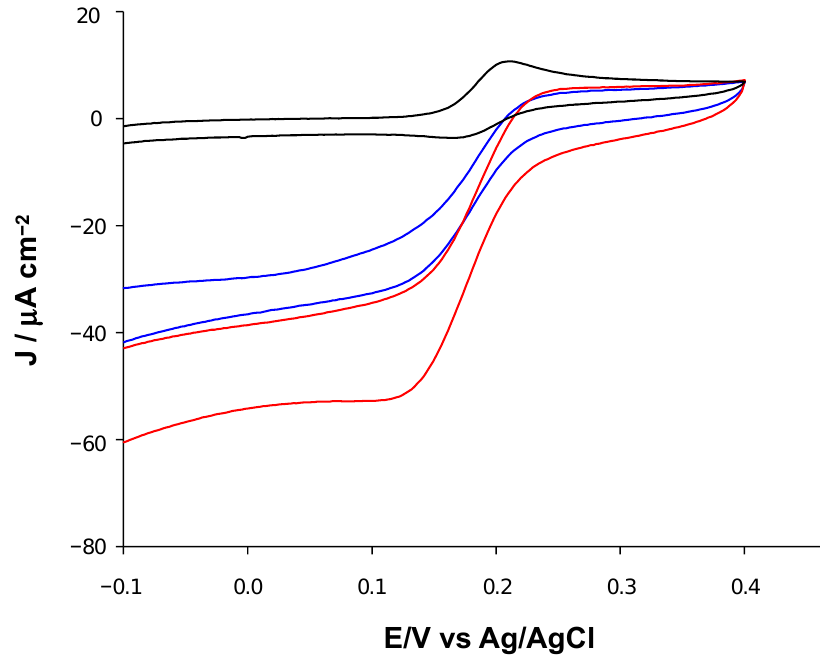
Figure 4. CVs of 50 µ M DA in PBS (0.1 M, pH 7.2, KCl 0.1 M) on a ChitNPs/GPH/SPE (black line), a LbL-Tyr (0.5 mg/mL)/ChitNPs/GPH/SPE (blue line), and a LbL-Tyr (0.5 mg/mL)/EDC-NHS/ChitNPs/GPH/SPE (red line). Scan rate: 10 mV s − 1